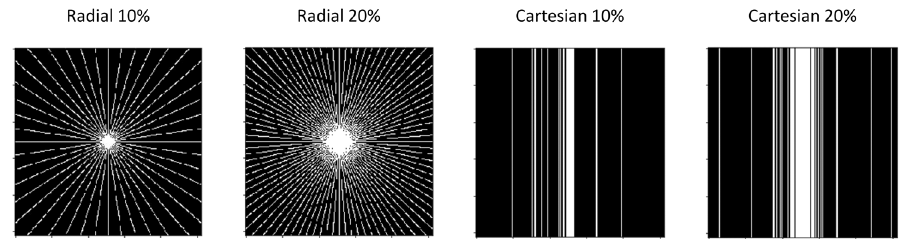
Figure 4. Radial and Cartesian sampling masks with different sampling rates (10% and 20%) in this study. White points indicate the sampled positions in the Fourier domain. The sampling rate is relative to the full sampling paradigm determined by the Nyquist sampling rule.